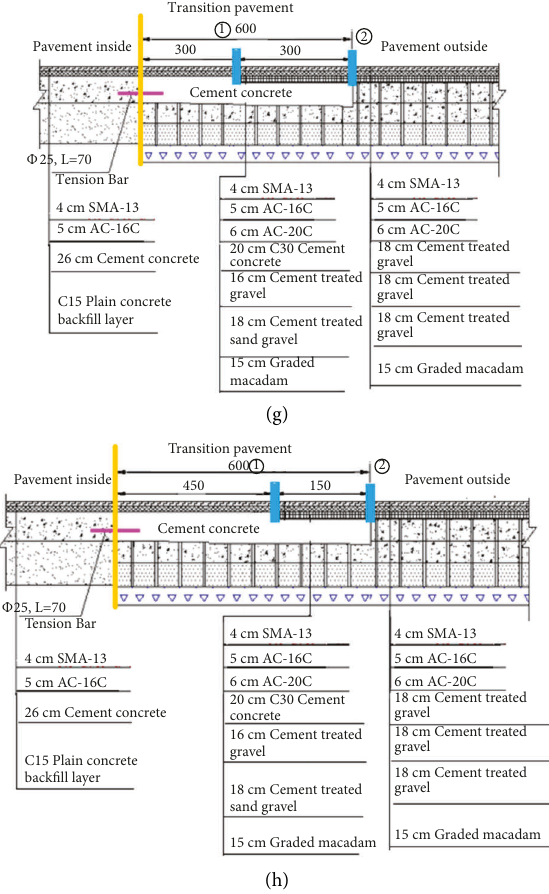
Figure 17: Str-1 and 7 alternative pavement structures. (a) Str-1. (b) Str-1a. (c) Str-1b. (d) Str-1c. (e) Str-1d. (f) Str-1e. (g) Str-1f. (h) Str-1g.